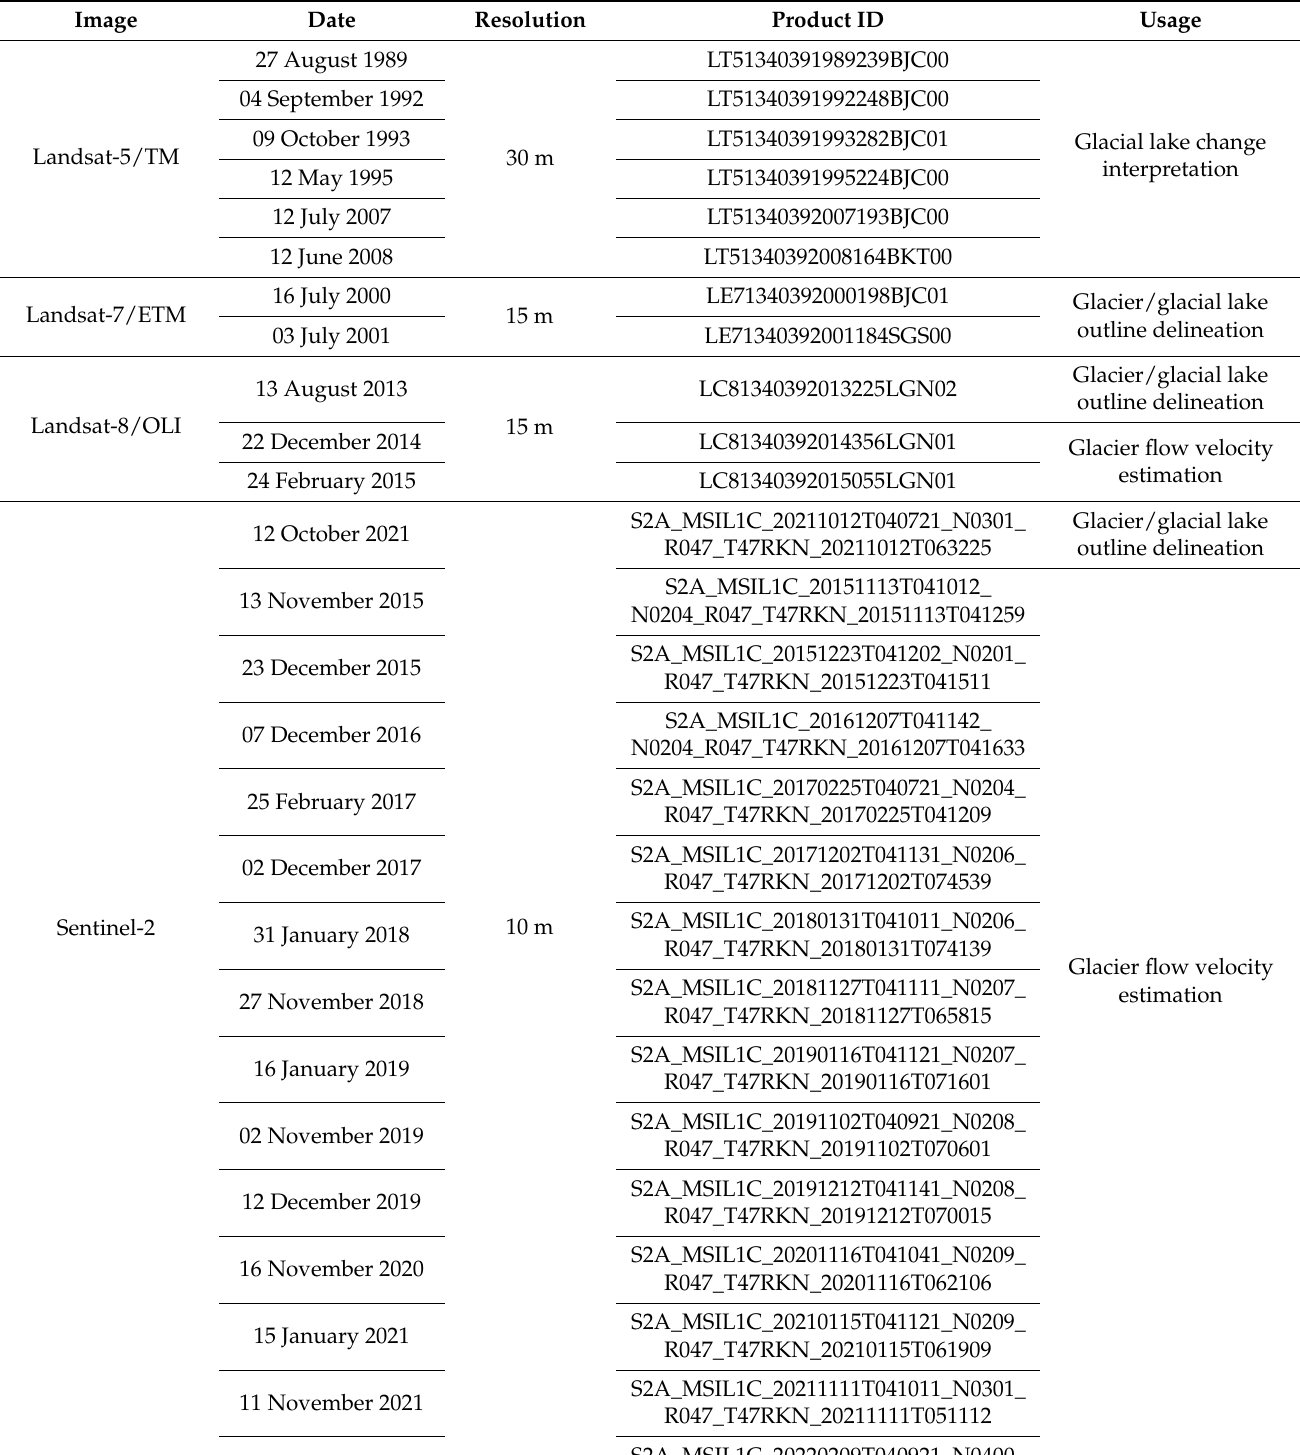
Table 1. Satellite images used in this